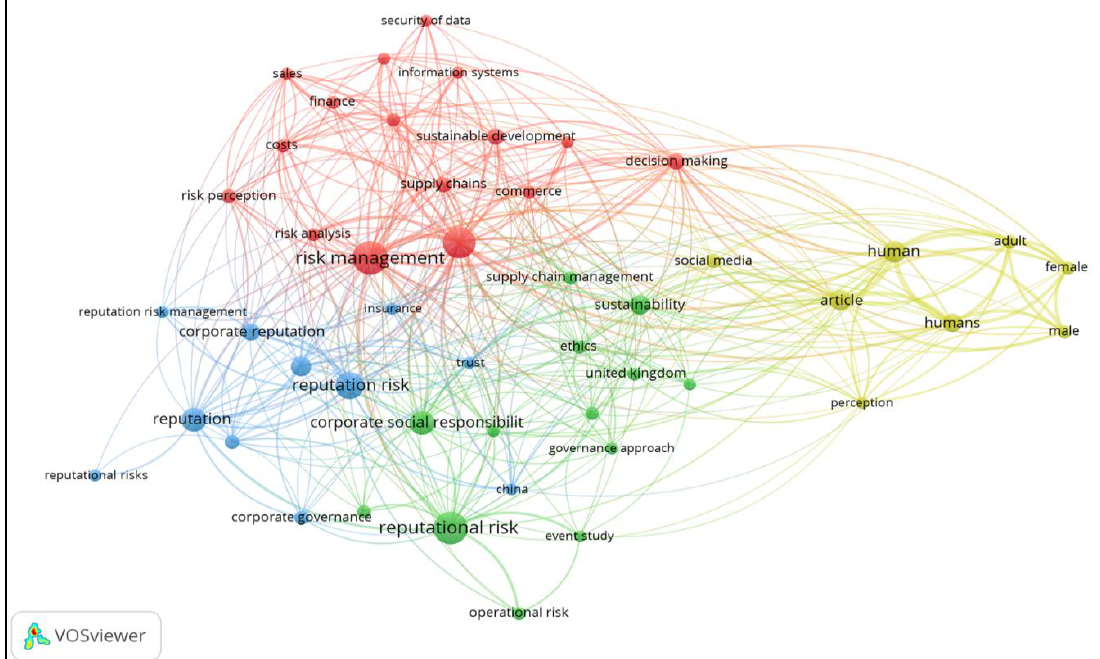
Figure 8. Keyword-wise published reputation risk papers map